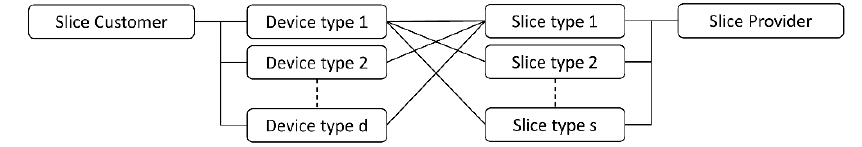
Figure 2. Slice Type